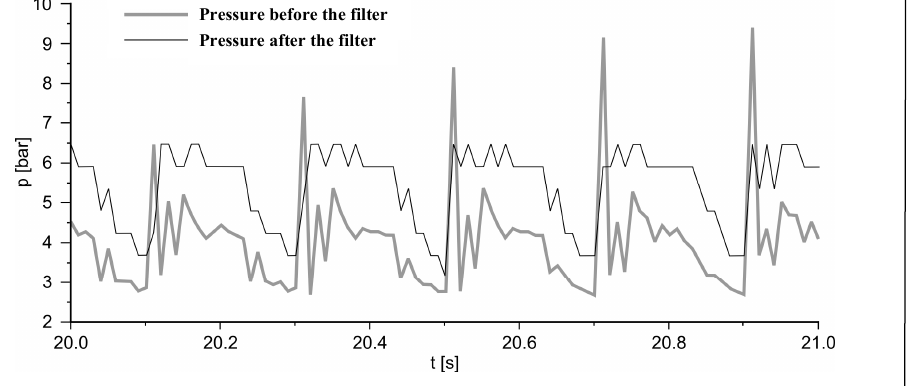
Figure 13 – Changes of pressure values in the filter block of the hammer return